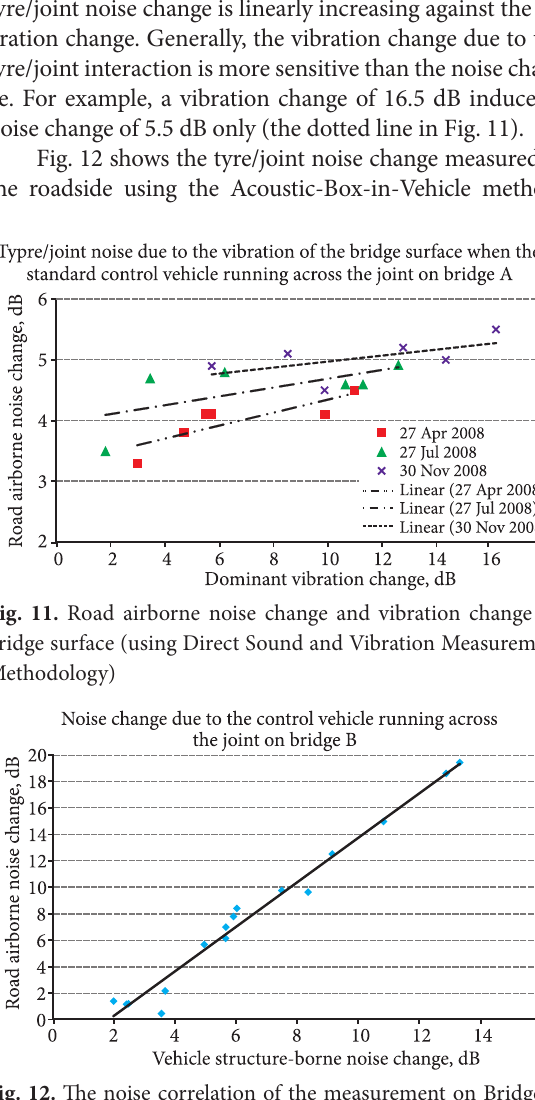
Fig. 12. The noise correlation of the measurement on Bridge B (using Acoustic-Box-in-Vehicle Methodology)